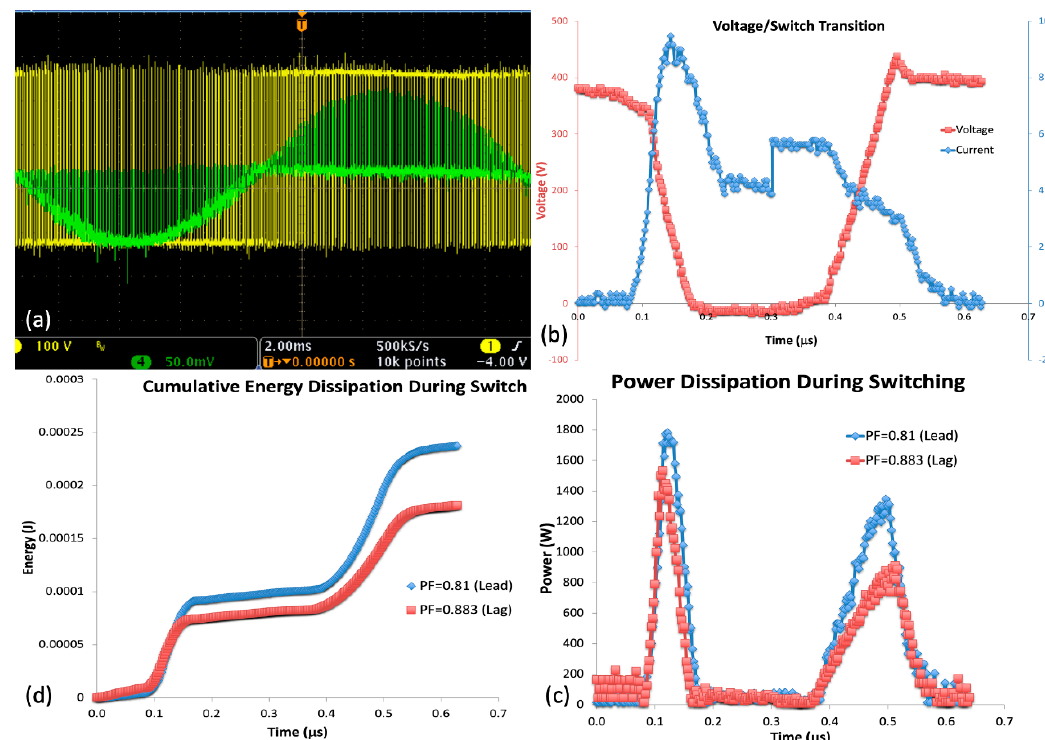
Figure 6. ( a ) Voltage (yellow) and current (green) waveforms of a MOSFET operating in an inverter. ( b ) Close-up of a single switch transition of the MOSFET. ( c ) Power profile of two different PF levels over the switch transitions showing increased power dissipation at crossover. ( d ) Energy losses can be calculated to be different according to PF.